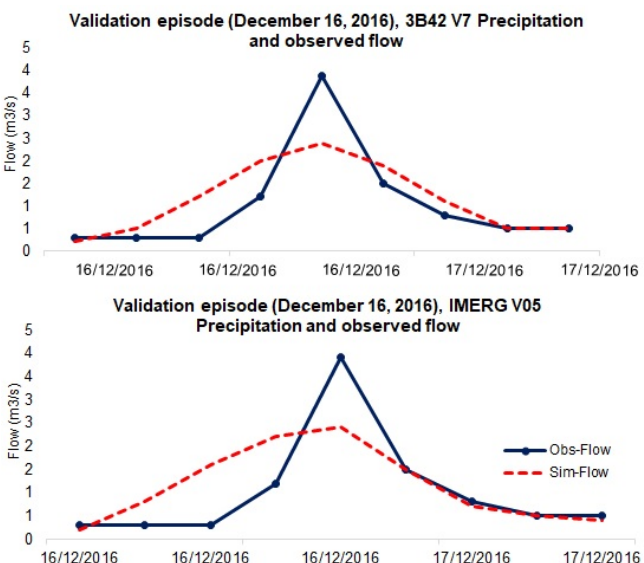
Figure 9. Validation of the episode of 16 December 2016, of 3B42V7 and IMERG V05 rainfall products and observed runoff data as input using the means calibration parameters of the gauge precipitation